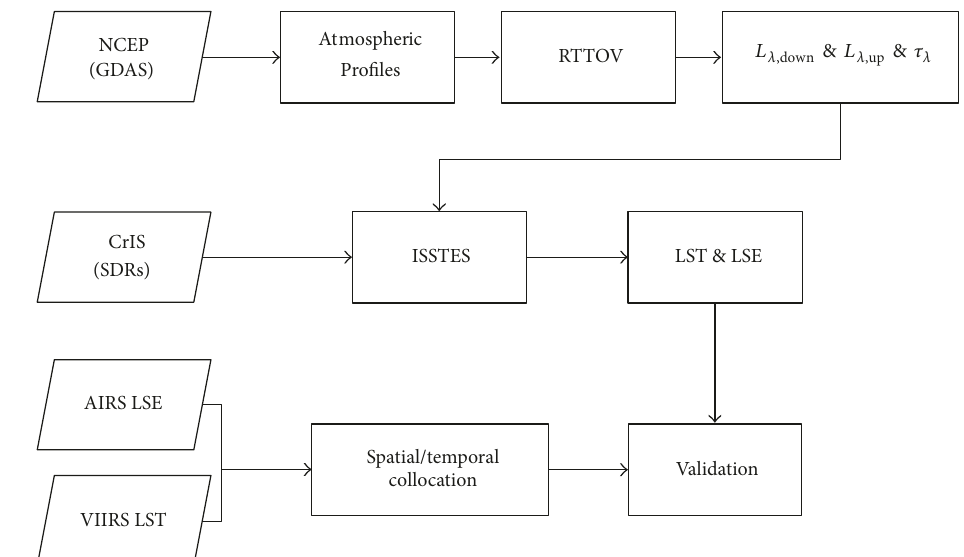
Figure 2: Flowchart of Temperature and Emissivity Separation with CrIS